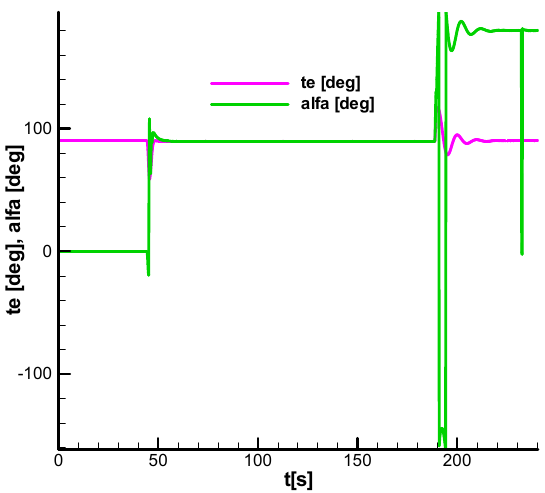
Figure 25. Diagram of the pitch angle ( te ) and the incidence angle ( alfa ).